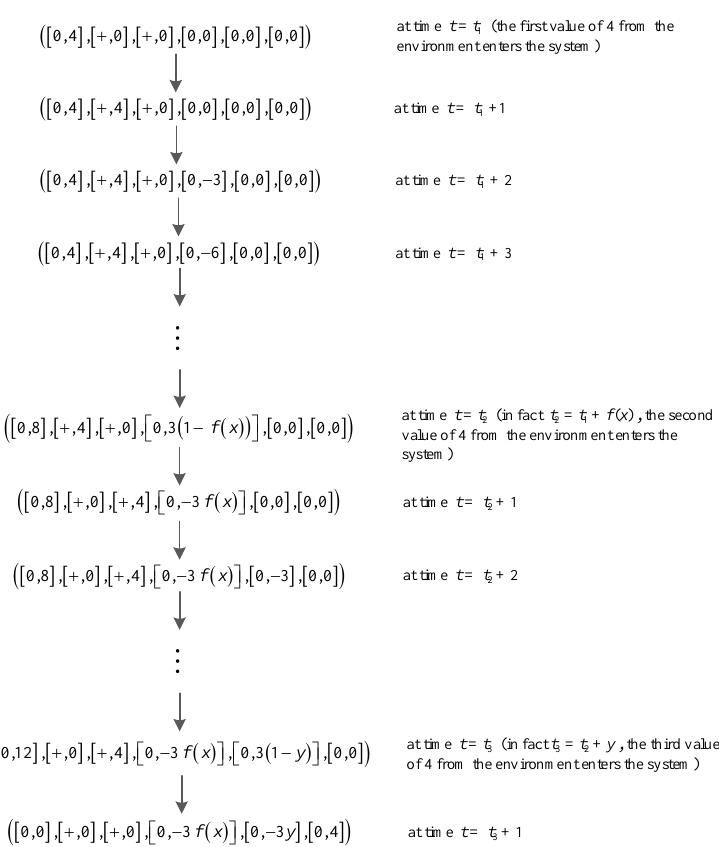
Figure 10. The INPUT module in system